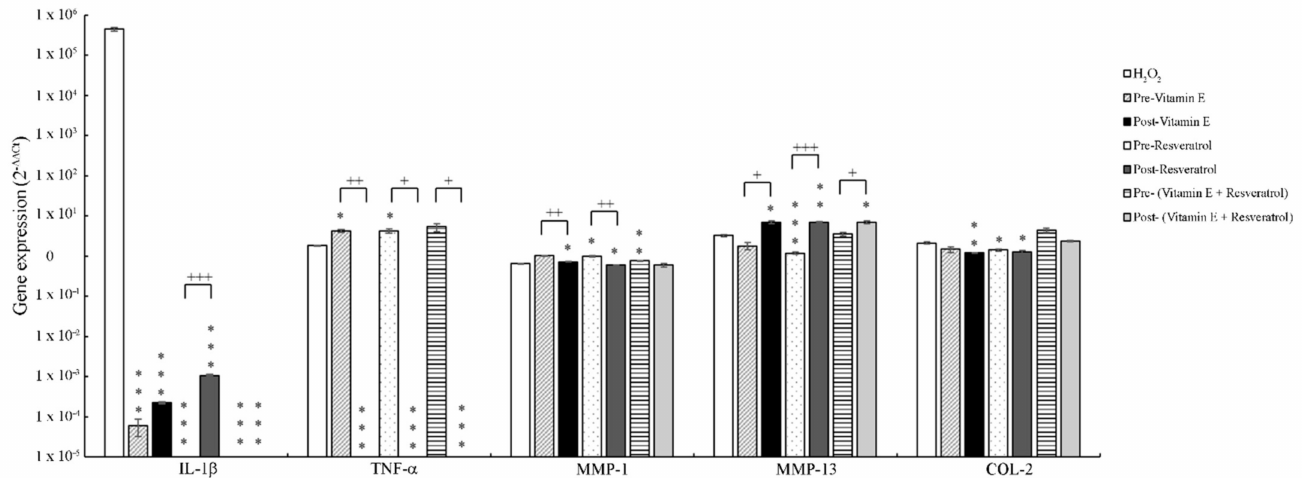
Figure 4. The inflammatory gene expression of OA-like chondrocytes when treated with vitamin E and resveratrol. The expressions of IL-1 β , TNF- α , MMP-1, MMP-13, and COL2A1 when the chondrocytes were pre-treated with 100 µ M of vitamin E (gray slashed bars), 5 µ M of resveratrol (black bars), or their combination (dotted bars), or when the chondrocytes were post-treated with vitamin E (dark gray bars), resveratrol (horizonal striped bars), or their combination (light gray bars). * p < 0.05, ** p < 0.01, and *** p < 0.001 compared with H 2 O 2 induction; + p < 0.05, ++ p < 0.01, and +++ p <